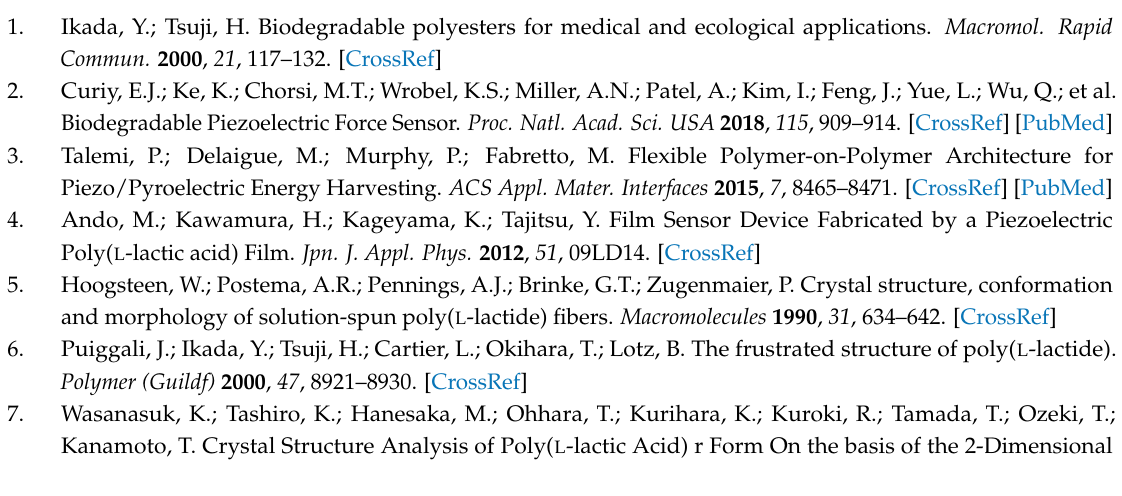
Figure S1: Relation between heat treatment time and Xc of no oriented PLLA films, Figure S2: Relation between heat treatment time and Xc of PLLAIL, Figure S3: XRD patterns of PLLAIL 0T films at each heat treatment time.